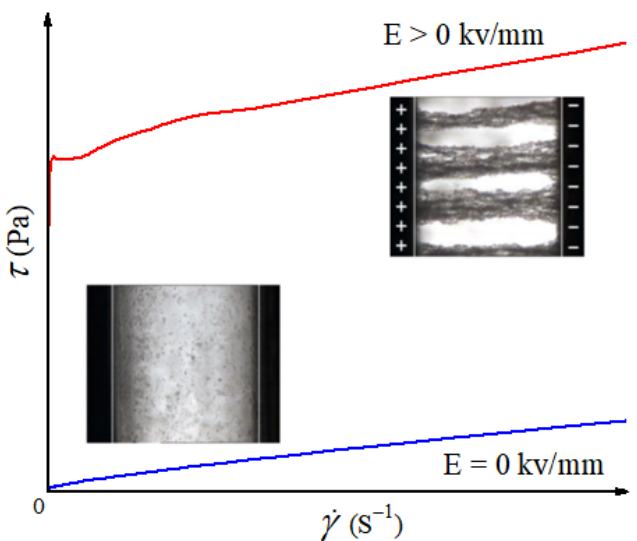
Figure 1. ER effect of ER fluids induced by electric field [23,24]. When E = 0 kV/mm, the particles are freely dispersed and the viscosity of fluids is low (blue line), while the particles align into a fibrous structure along the electric field direction when E > 0 kV/mm and the viscosity of fluids is significantly increased (red line).